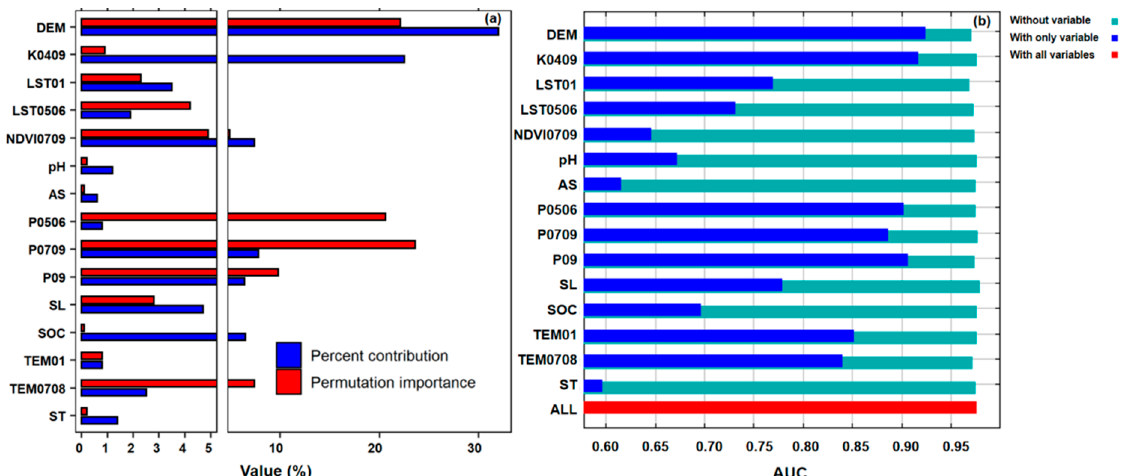
Figure 4. The percent contribution and permutation importance of each environment variable ( a ) and AUC values of each environment variable from the jackknife test ( b ). “With all variables” represents the AUC of the model using all variables, “With only variable” represents the AUC of the model using only one variable, and “Without variable” represents the AUC of the model using all except one variable.